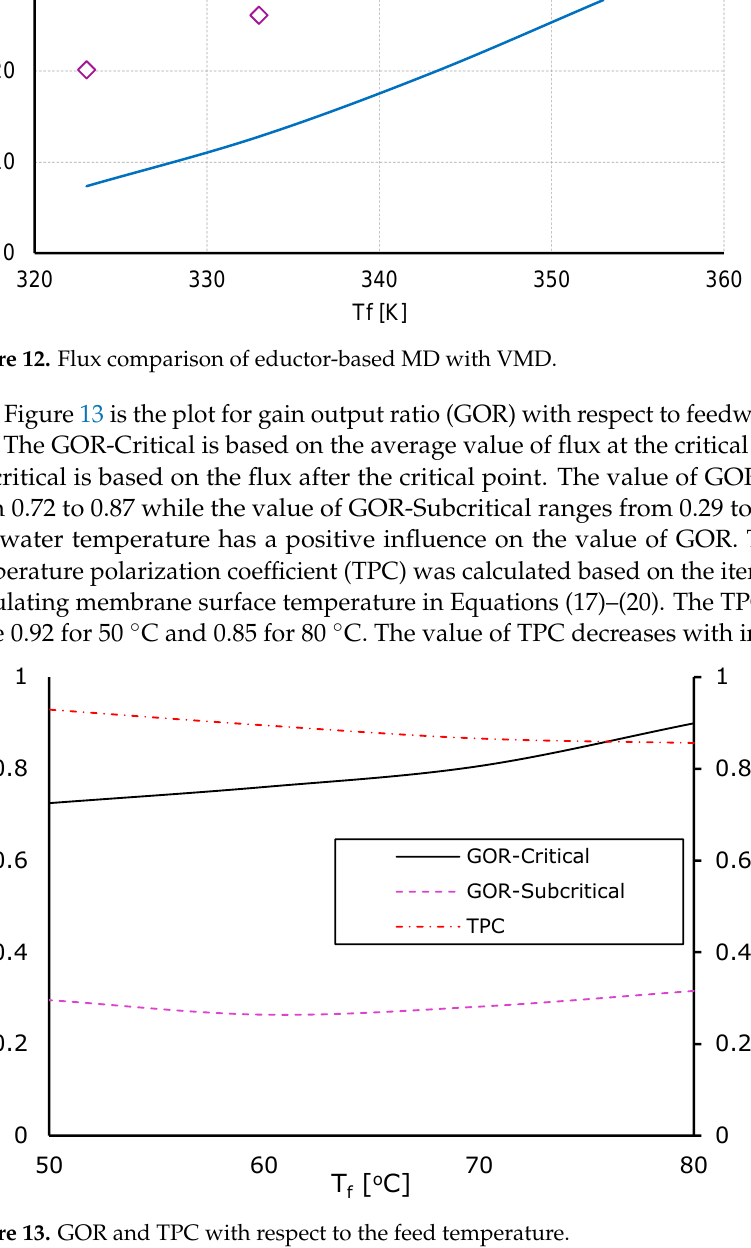
Figure 13. GOR and TPC with respect to the feed temperature.